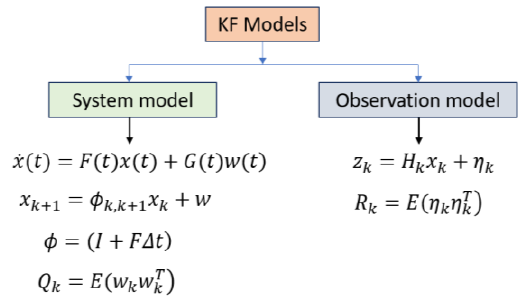
Figure 16. Kalman Filter system and observation models’ equations.